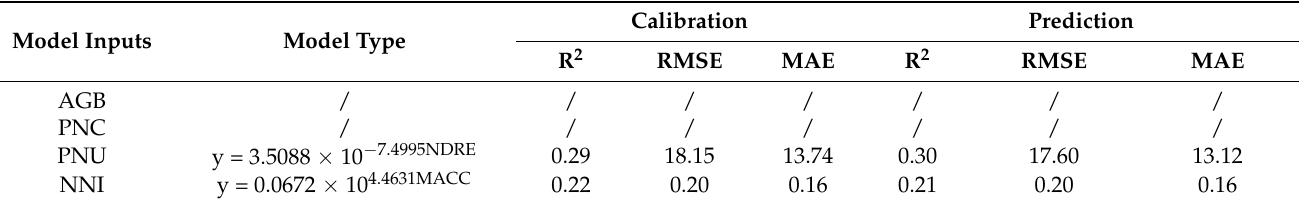
Table 6. The performance of singular variable regression models developed for predicting four different N status indicators.